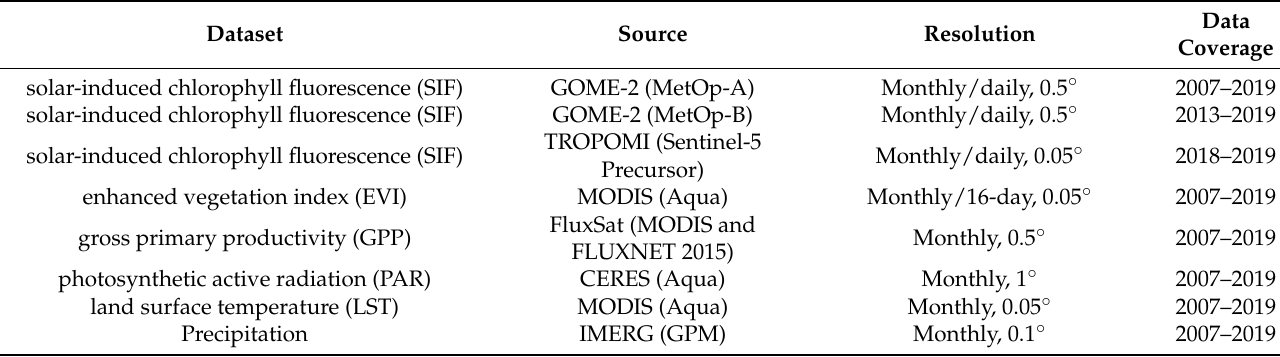
Table 2. Summary of satellite-based